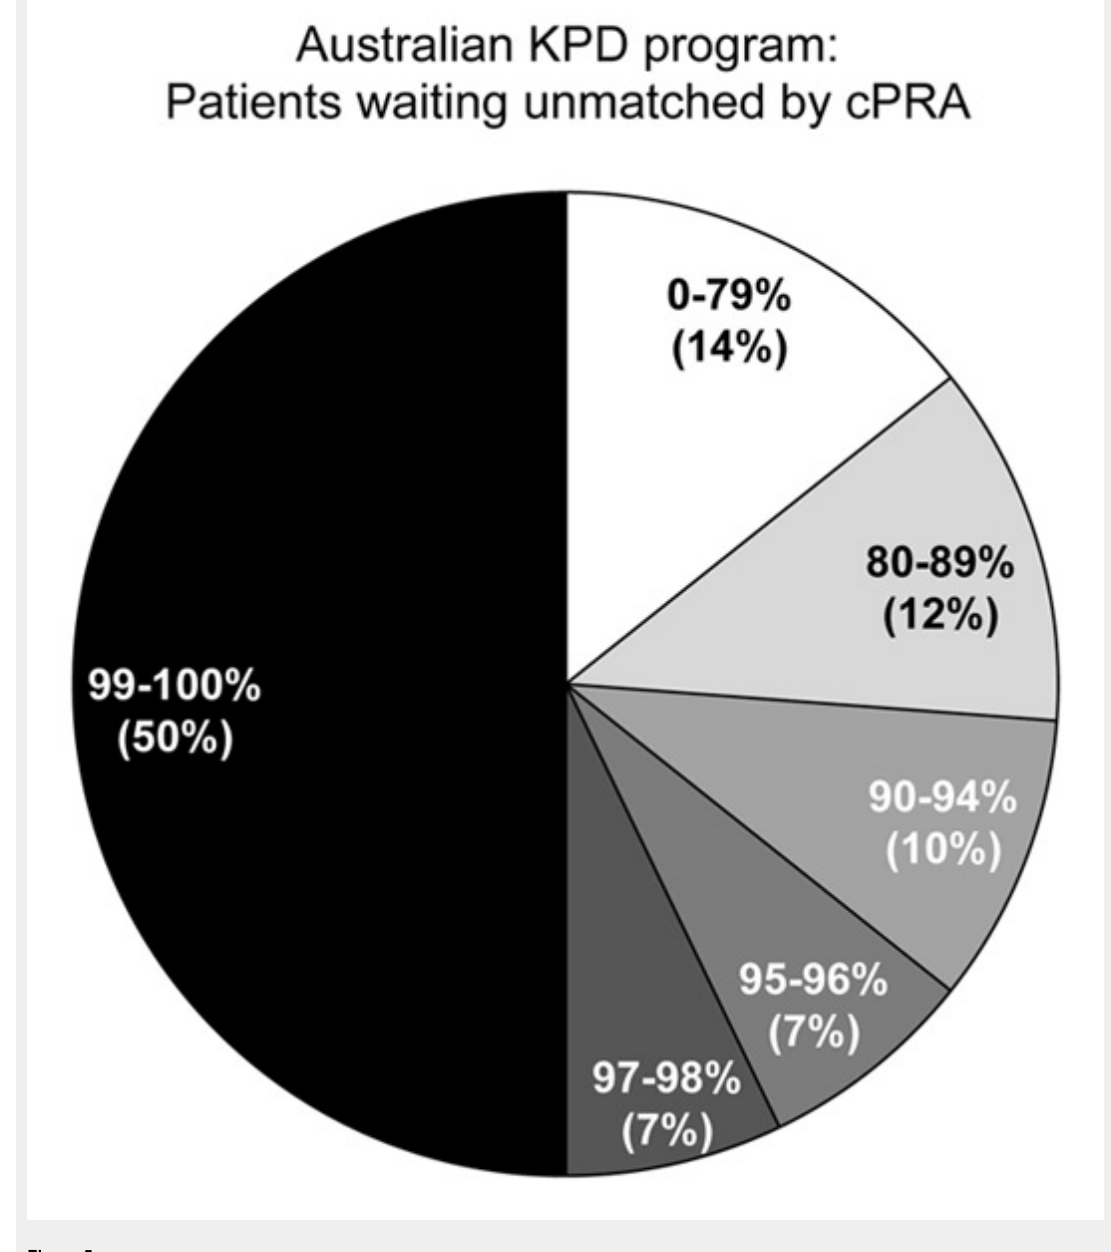
Figure 5 Level of sensitisation of 38 transplant candidates still waiting unmatched in the Australian KPD programme after at least two match cycles. Two thirds of patients waiting are highly sensitised with a cPRA